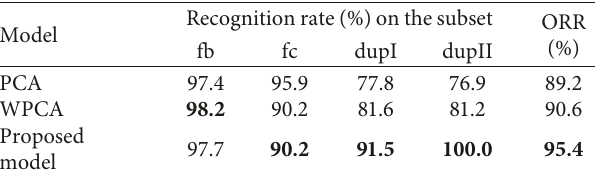
Table 2: Comparison results of different face recognition methods with POEM features. Model